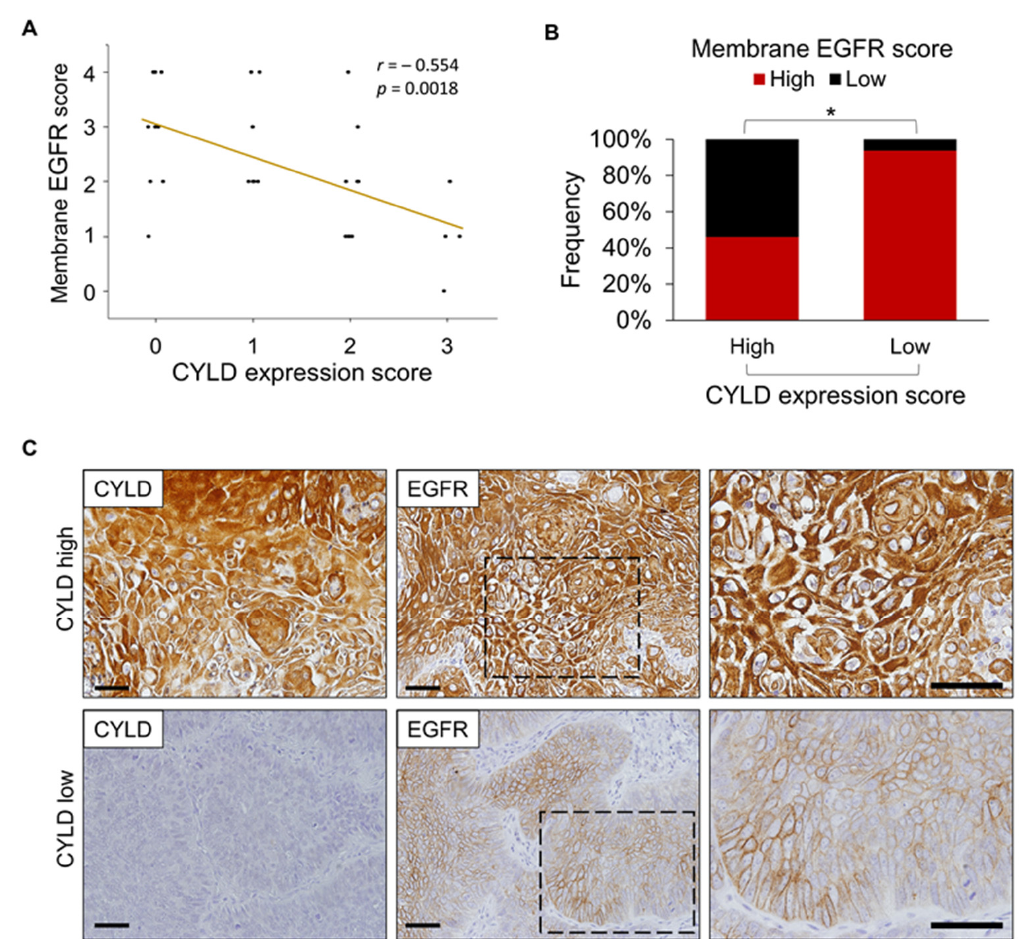
Figure 4. CYLD expression and subcellular EGFR localization in human HNSCC tissues. ( A ) Relationship between CYLD expression score and membrane EGFR score in primary HNSCC tissues. ( B ) Percentage of specimens with low or high CYLD expression scores compared with membrane EGFR scores. The membrane EGFR score was determined based on the percentage of tumour cells showing dominant EGFR localization in the cell membranes (see Materials and Methods for scoring details). * p < 0.01 (Pearson’s χ 2 test). ( C ) Examples of high CYLD expression for low membrane EGFR scores and low CYLD expression for high membrane EGFR scores. The images on the right provide enlargements of the boxed areas in the middle images. Scale bars, 100 µm.